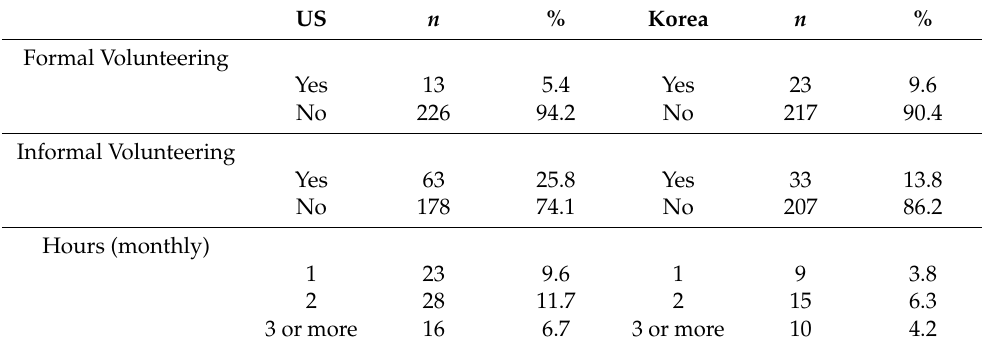
Table 3. Types of volunteering and hours (monthly) (US: n = 240 & Korea: n = 240). US n % Formal